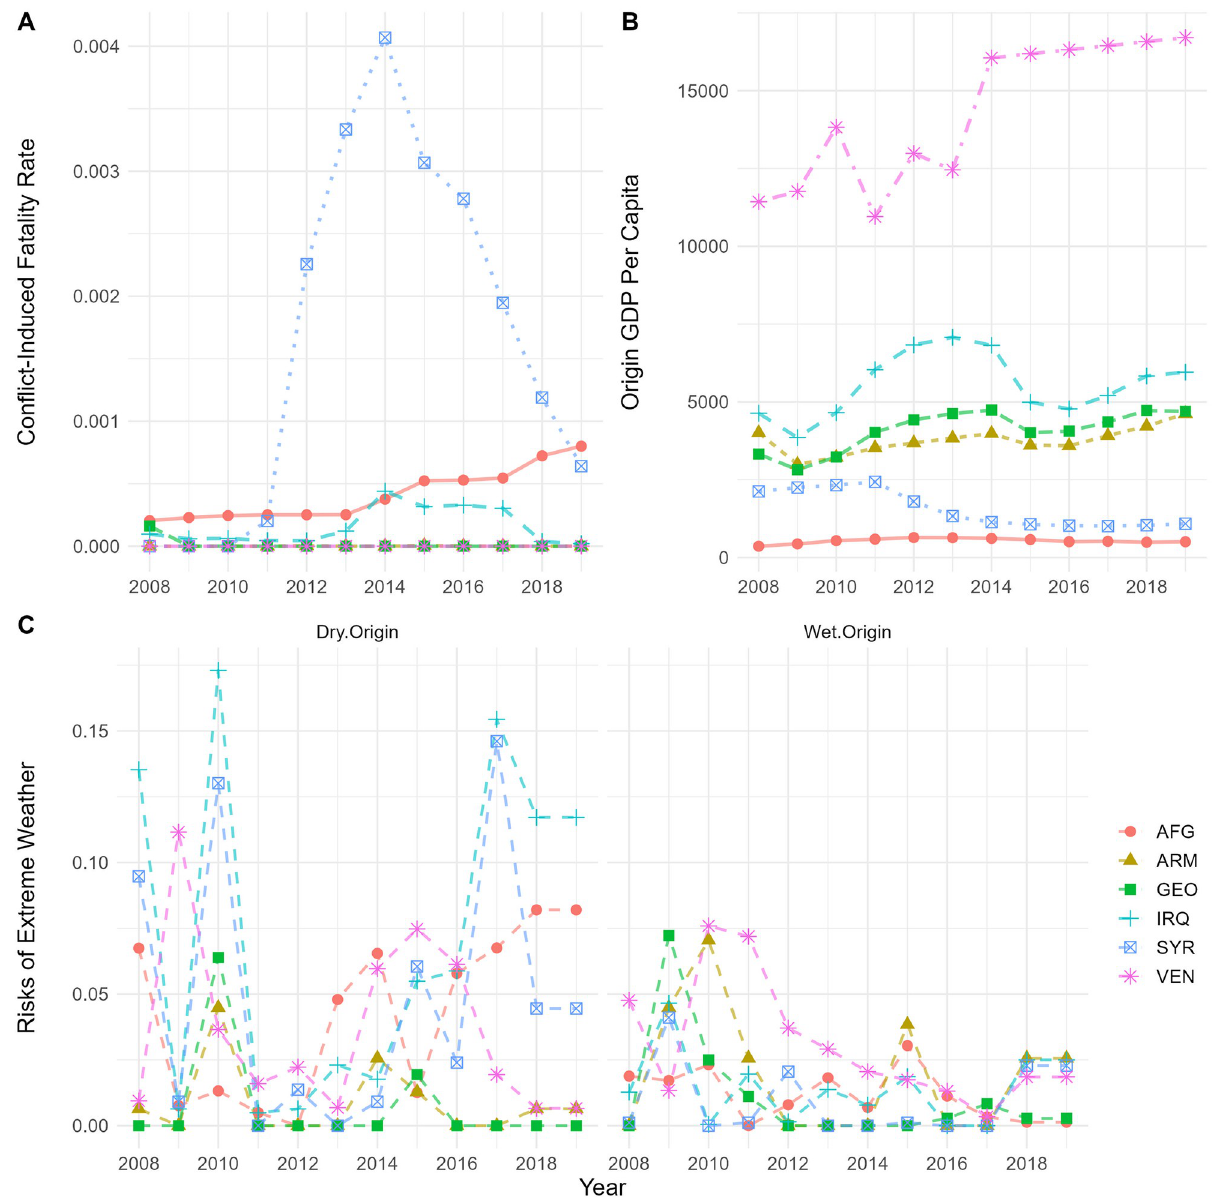
Fig 3. Conflict, economic, and climate data. A: Trends in conflict–induced mortality rates. B: Trends in GDP per capita. C: Trends in risks of extreme dry and wet weather condition derived from the Standardised Precipitation–Evapotranspiration Index (SPEI).